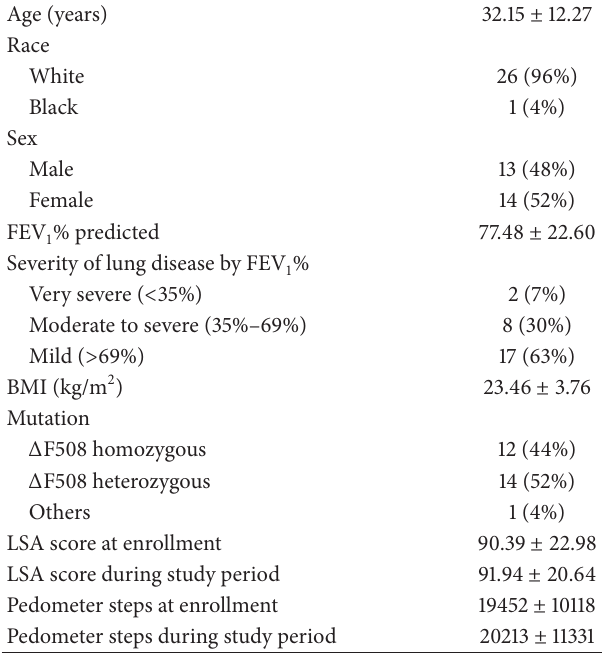
Table 1: Demographics of adult subjects with cystic fibrosis ( 𝑁 = 27